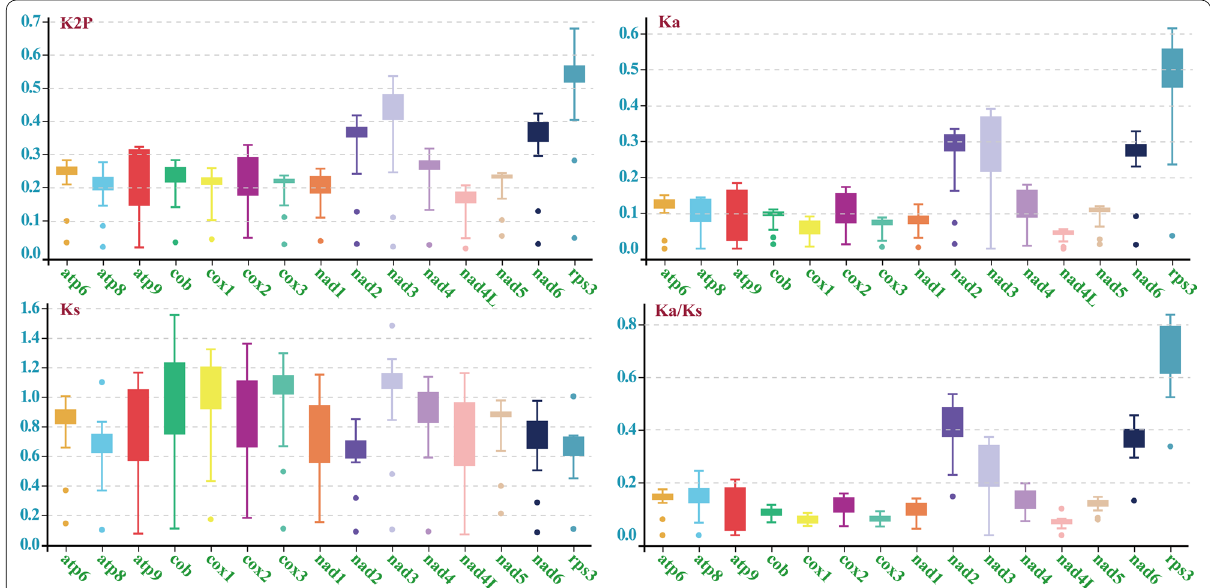
Fig. 6 Genetic analysis of the 15 core protein coding genes in the 6 Phallomycetidae species. K2P, the Kimura-2-parameter distance; Ka , the number of nonsynonymous substitutions per nonsynonymous site; Ks , the number of synonymous substitutions per synonymous